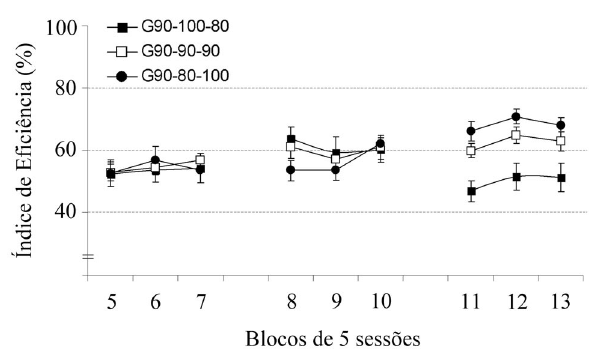
Figura 3 . Média (±EP) dos Índices de Eficiência (%) dos grupos G90-100-80, G90-90-90 e G90-80-100 em três blocos de cinco sessões cada, durante o treino (blocos 5-6-7), Teste 1 (blocos 8- 9-10) e Teste 2 (blocos 11-12-13) em DRL-20